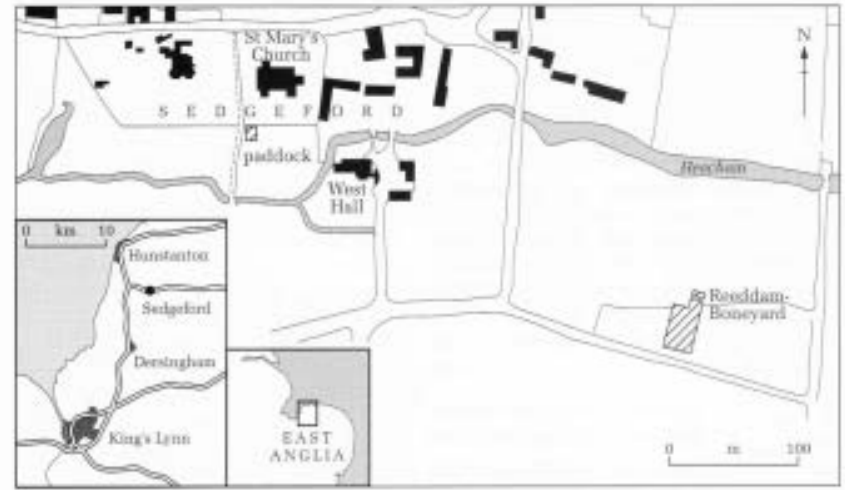
Figure 1 The location of Sedgeford in northwest Norfolk, showing the two main study areas of the project: St Mary's Church-Paddock-West Hall and the Boneyard-Reedam